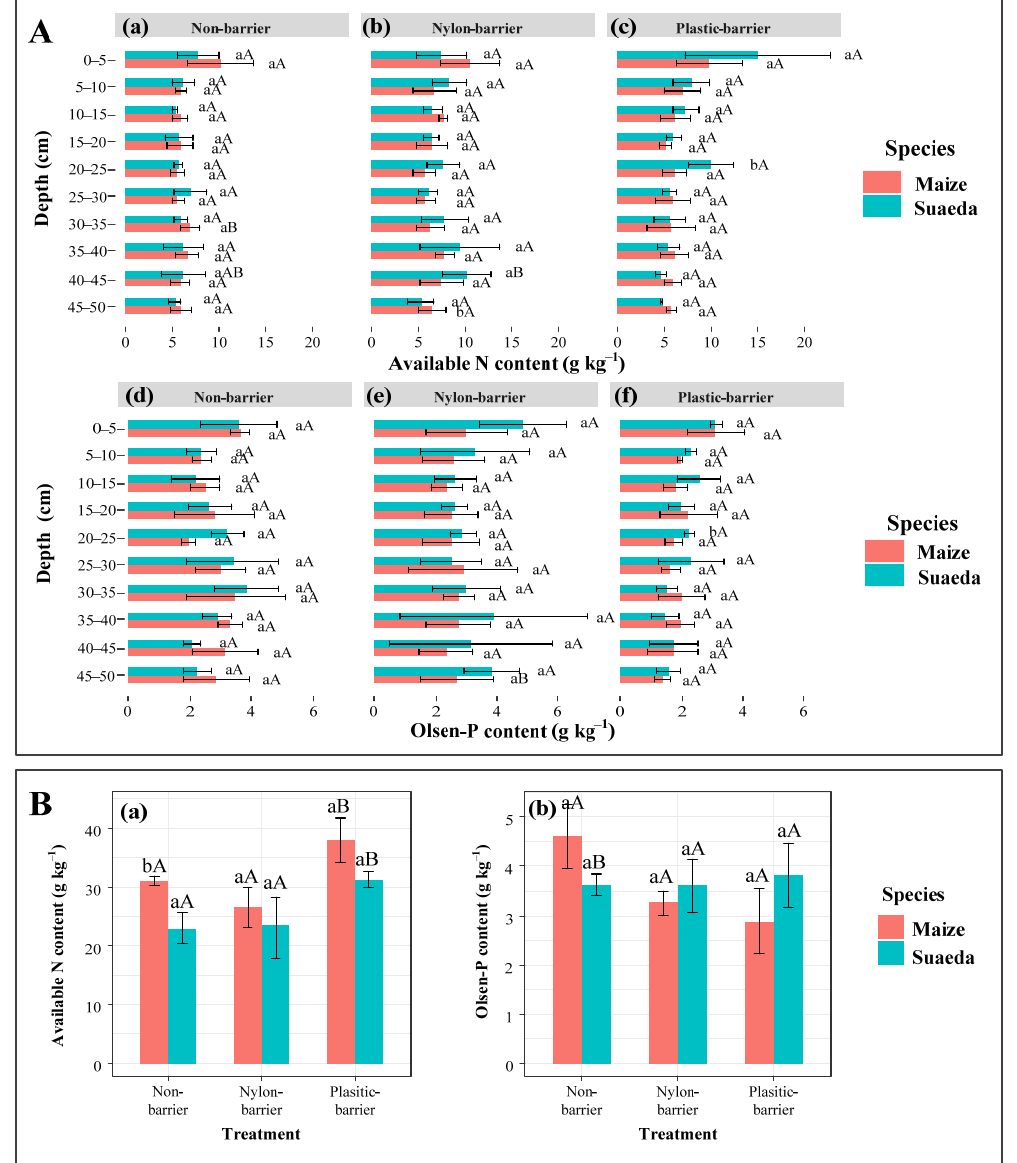
Figure 5. The available N and Olsen-P contents in the different treatments: ( A ( a – c )) Available N contents in non-, nylon-, and plastic-barrier treatment of field experiment; ( A ( d – f )) Olsen-P contents in non-, nylon-, and plastic-barrier treatment of field experiment; ( B ( a , b )) Available N, Olsen-P concentration of pot experiment. Capital letters on the column indicate the significant differences among three treatments. Lower case letters on the column indicate significant differences between two species.